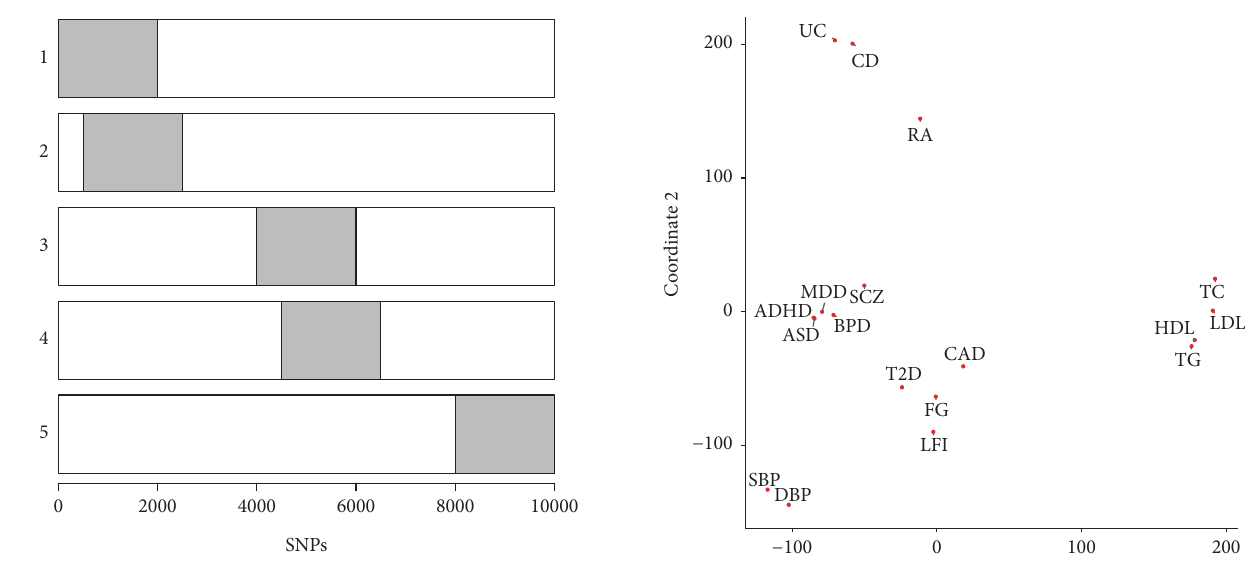
Figure 2: Design of simulation study. Each box indicates a GWAS study and 𝑥 -axis represents the SNP index. The gray box within each box indicates risk SNPs. In this study, we considered five phenotypes and 20 % of the SNPs were assumed to be risk SNPs for each phenotype. We further assumed that 75 % of risk SNPs were shared between phenotypes 1 and 2 and also between phenotypes 3 and 4 to generate pleiotropic structure. Phenotype 5 did not share any risk SNPs with any other phenotypes as a negative control.